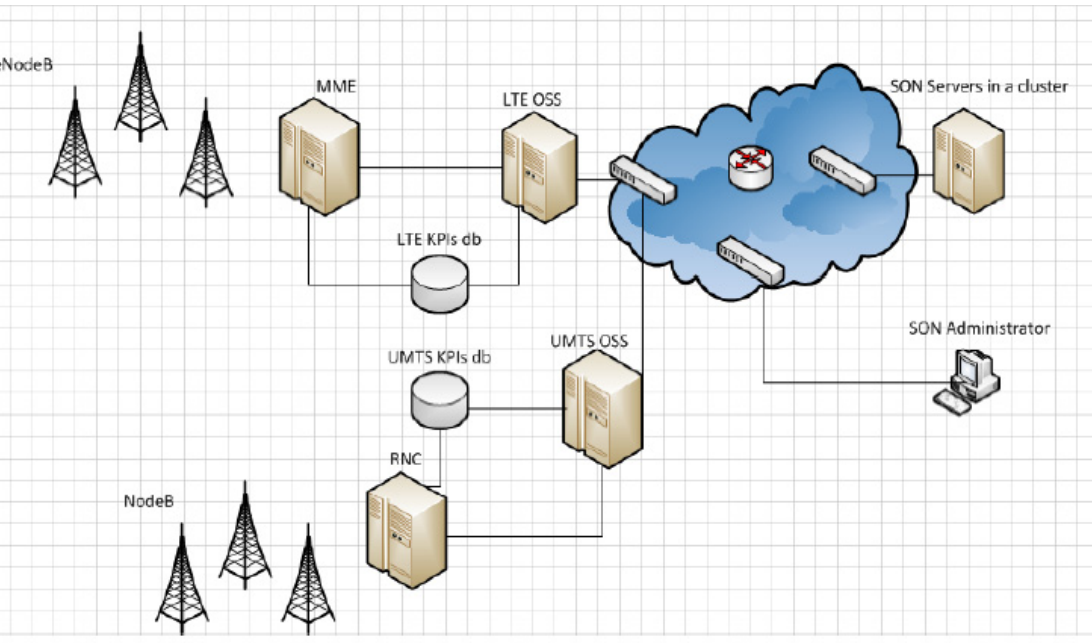
Figure 6. Interconnection of SON server cluster with UMTS and LTE OSS (centralized architecture).